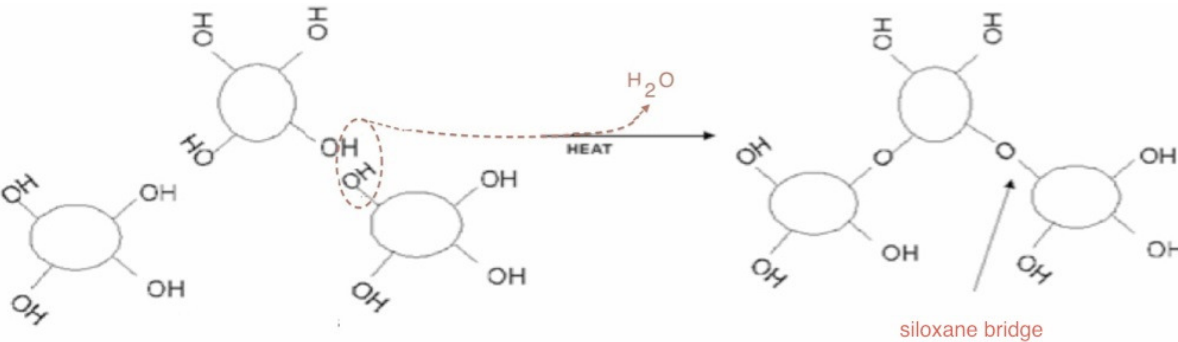
Figure 5. XRD patterns of LaNi